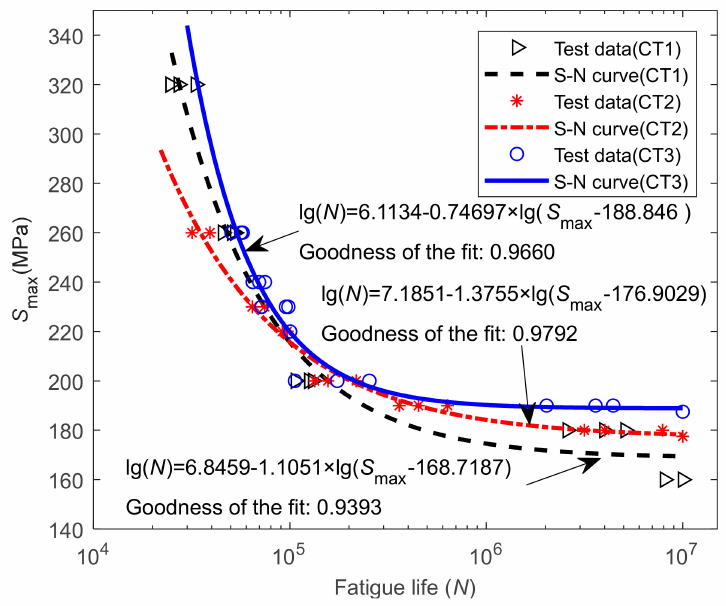
Figure 3. S-N curves of 7075 aluminum alloy at di ff erent prebending radii.